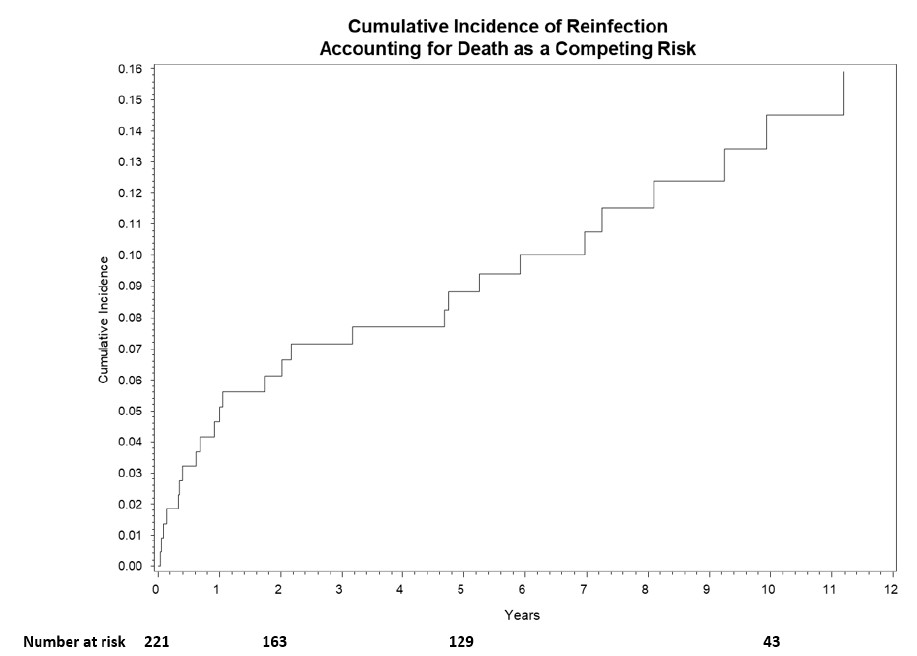
Figure 4. Cumulative incidence curve for reinfection. Overall incidence at 1-year, 3-year, and 5-year was 5% (95% CI: 2–8%), 7% (95% CI: 4–11%), and 9% (95% CI: 5–13%), respectively.